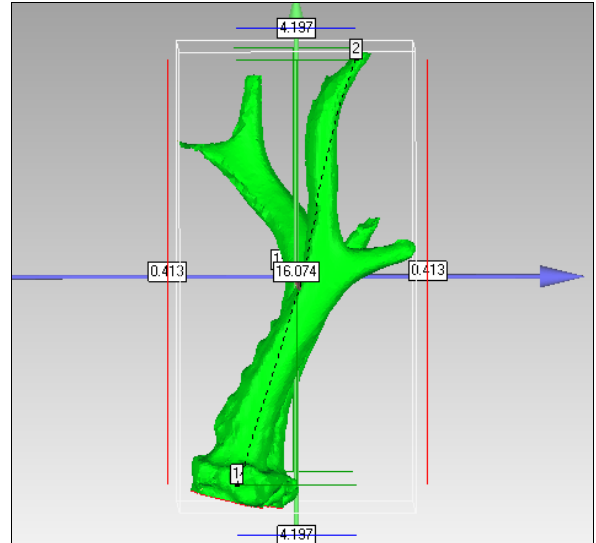
Figure 10. Antler length measurement on the 3D model